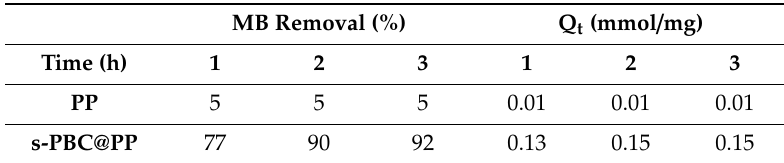
Table 1. MB removal (%) and amount of adsorbed dye Q t (mmol per mg of coupons), considering the peak at 664 nm.